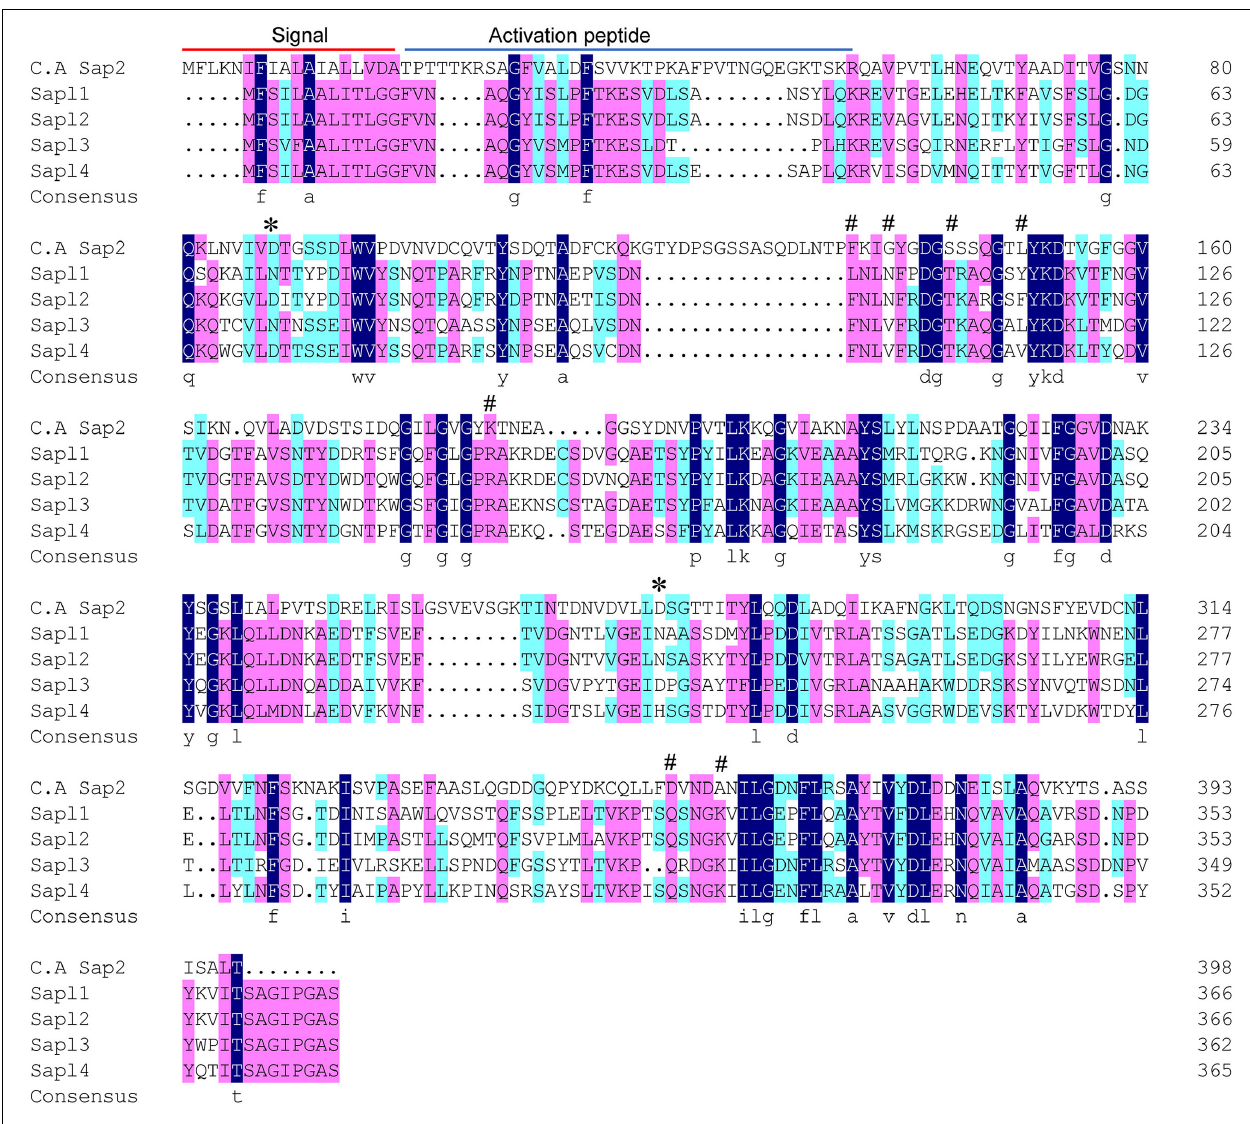
FIGURE 2 | Protein sequence alignments of Sap2 ( C. albicans ), Sapl1, Sapl2, Sapl3, and Sapl4 ( S. bombicola ). The blocks in dark blue indicated the conserved domains, the residues marked with * represented the active sites, and the residues marked with # represented the inhibitor binding